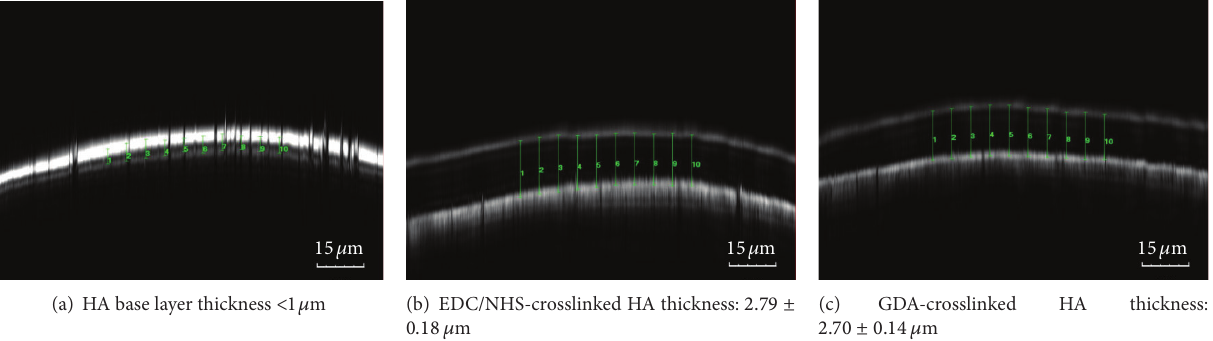
Figure 6: Representative height profiles ( 𝑥𝑧 scans) determined by confocal microscopy of (a) HA base layer, (b) EDC/NHS-crosslinked HA coatings, and (c) GDA-crosslinked HA coatings on GPTMS-modified surfaces. The indicated thickness ± standard deviation has been averaged over 2 positions along the PA12 tube with each ten measurement points.